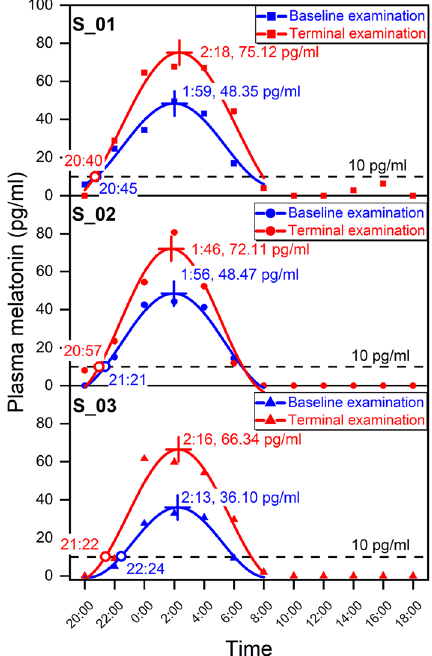
Figure 1. The plasma melatonin concentrations and their cosine fitting functions for three subjects. The symbols represent the measured melatonin concentrations. The lines are the cosine fitting functions of these points. The blue points and lines represent the melatonin patterns in the baseline examination (D7 20:00–D8 6:00). The red points and lines represent the melatonin patterns in the terminal examination (D46 20:00–D47 18:00). (The figure was generated by Origin 2018, URL: https:// www. origi nlab. com/).